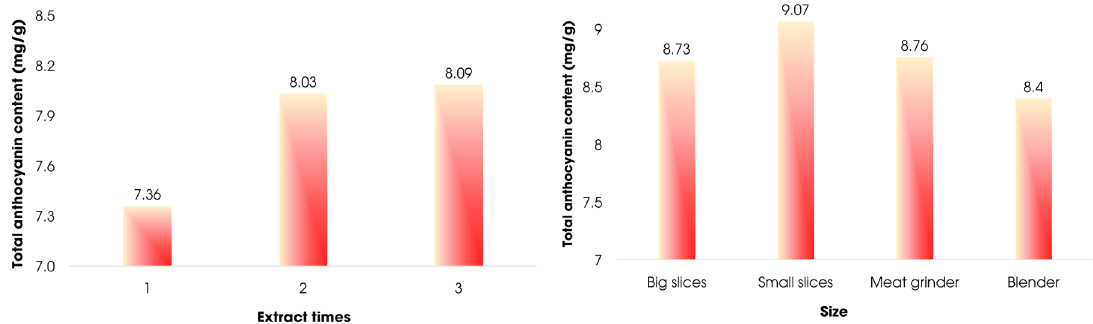
Figure 7. Extraction yields of fruits with relation to extraction cycles and material sizes.